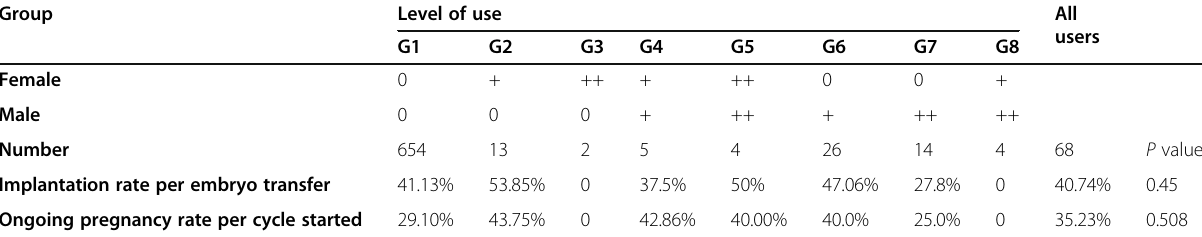
Table 3 Treatment outcome for 722 IVF patients based on the level of cannabis use: implantation rate (IR) and ongoing pregnancy rate (OPR) among the different study groups as well as combining all users. The symbols in the first two rows define the level of use for the two partners: 0, no use; +, light use; ++, heavy use Group Level of use All